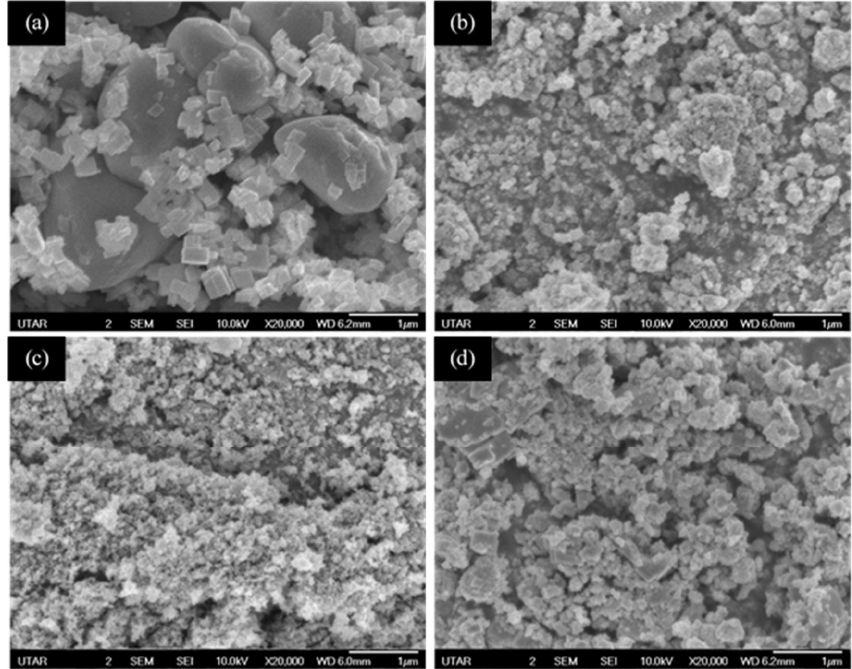
Figure 3. FESEM images of ( a ) HPOM, ( b ) f ‐ MNPs, ( c ) f ‐ MNPs ‐ TiO 2 composite, and ( d ) f ‐ MNPs ‐ HPOM composite at 20,000× magnification.